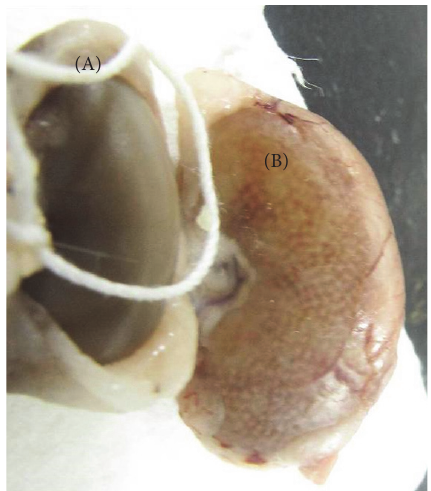
Figure 2: Gross morphology of rat kidney in normal group (A) and kidney impaired group (B). Rats in kidney impaired group were intragastrically treated with adenine (400mg/kg × 5 days), while those in normal group were treated with normal saline of the same volume. The kidney (A) in normal group was normal, with a smooth surface (weighing 0.935 ± 0.113 g); and the kidney (B) in kidney impaired group was swollen with numerous white dots (weighing 1.917 ± 0.156 g).